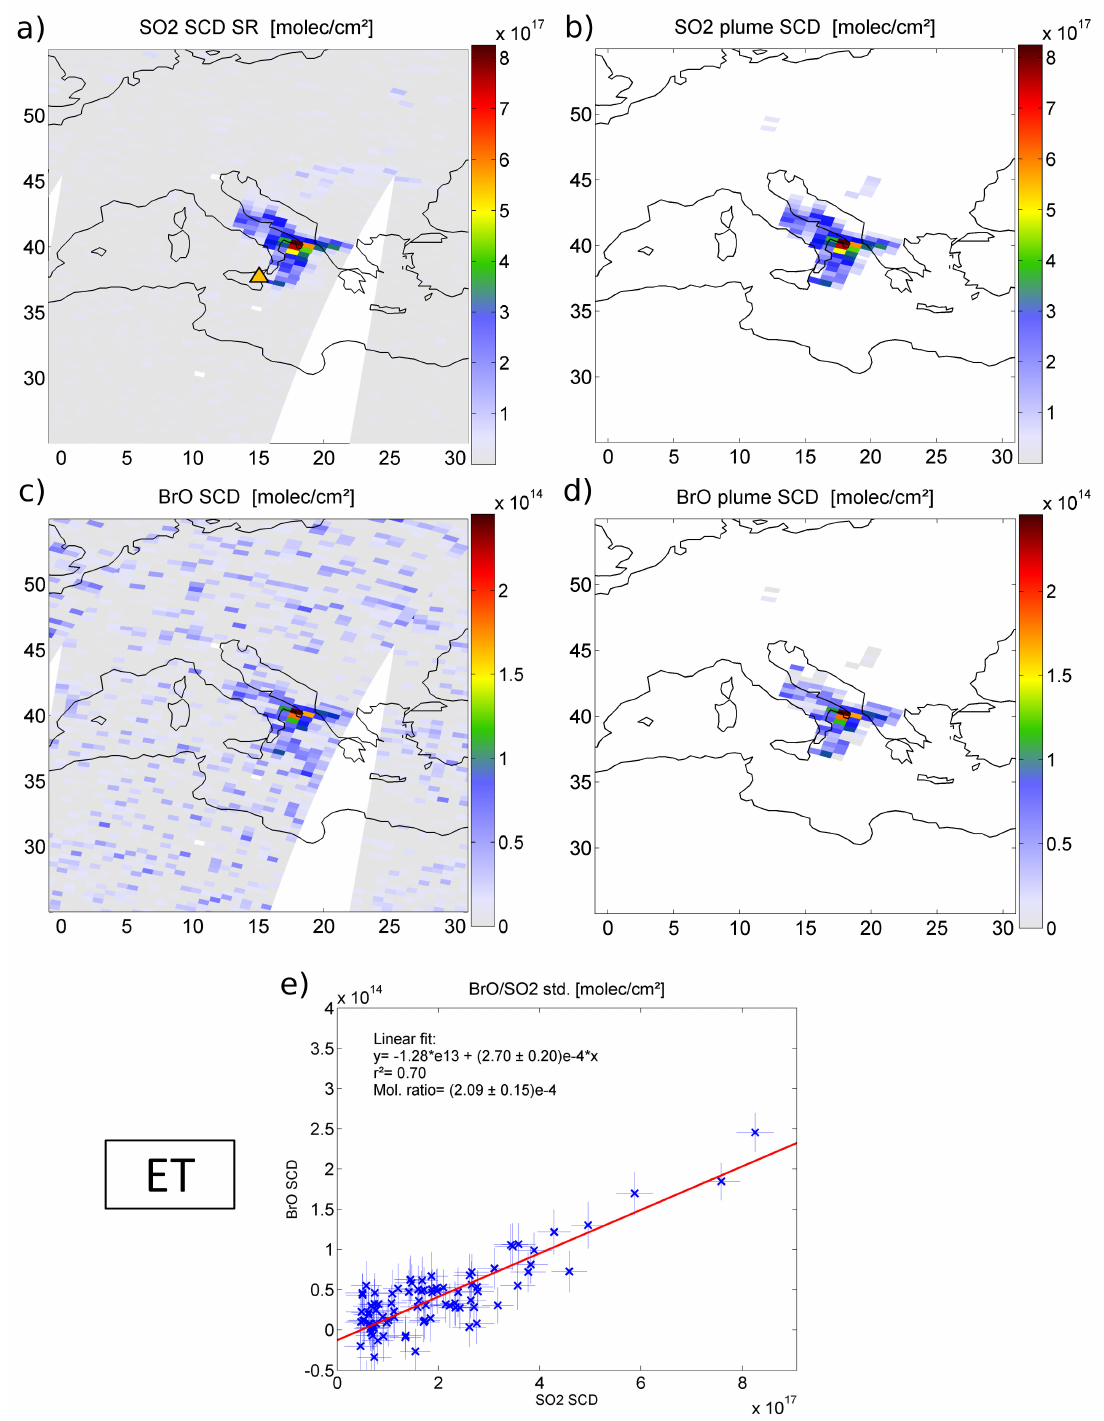
Fig. 7. SO 2 and BrO SCDs during an eruptive phase of Mt. Etna on 14 May 2008. The SCDs for SO 2 and BrO ( a and c ) show that the BrO SCDs were clearly enhanced in the vicinity of the SO 2 plume and even have a similar distribution. (b) and (d) show only those satellite pixels, that are supposed to represent the volcanic plume (SO 2 VCD ∗ > 3 σ ∗ ). The correlation plot for the identified plume pixels (e) shows a linear relationship between the two species ( r 2 =0.7) and a fitted mean BrO/SO 2 ratio of (2.7 ± 0.2) × 10 − 4